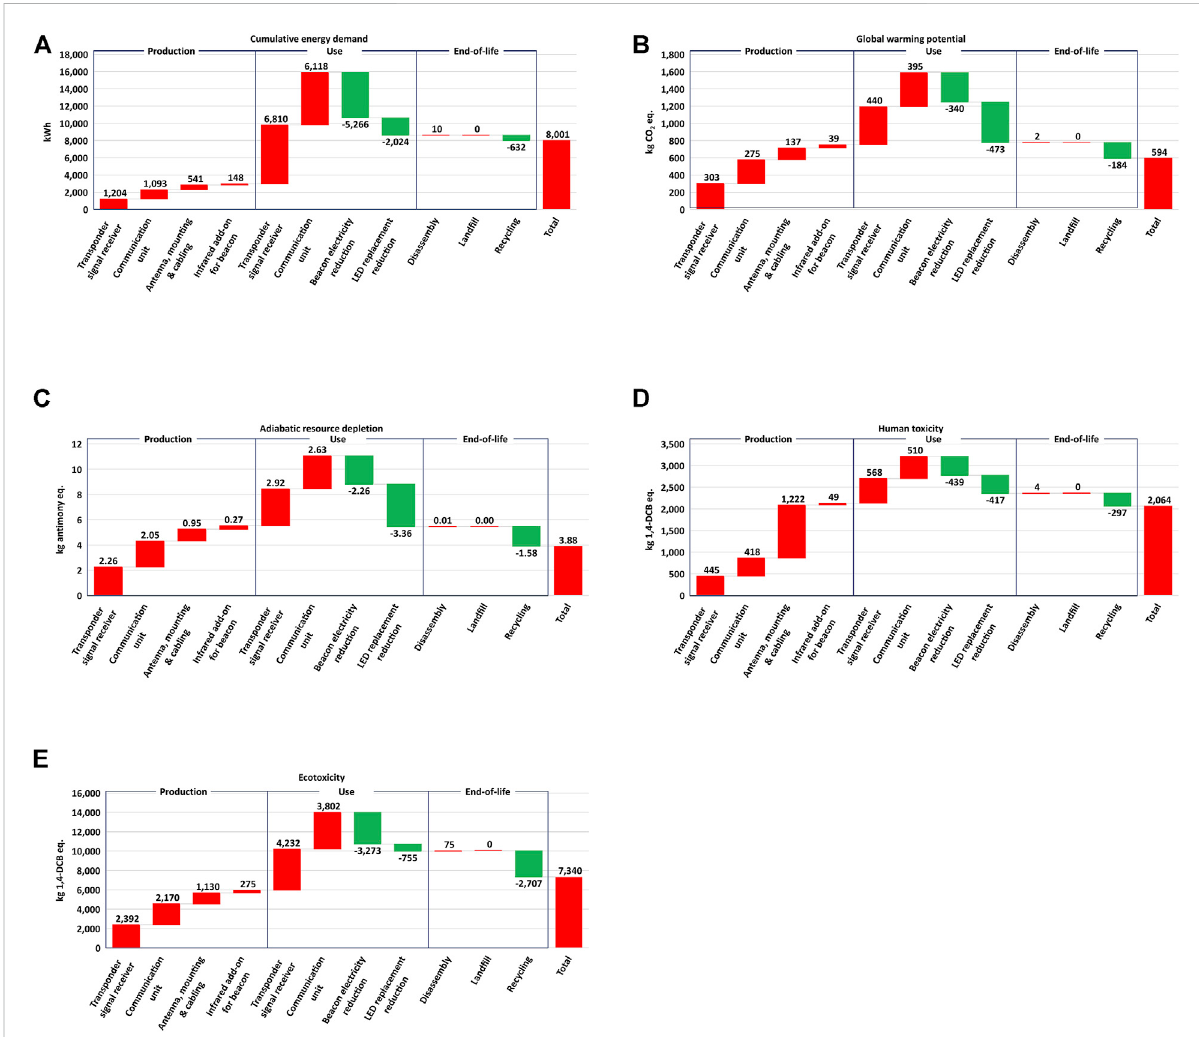
FIGURE 4 Life cycle impact assessment for the base case. Functional unit: one ADLS in thebase case. (A) Cumulative energy demand; (B) Global warming potential; (C) Adiabatic resource depletion; (D) Human toxicity; (E) Ecotoxicity.